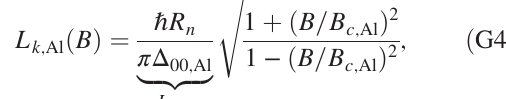
− f 1 as a function z Þ 0 . The for B z y ¼ as a function of B extracted from i z − 0 . 1 mT, reaching a factor of z ¼ value in zero field [see Fig. 5(b), blue i